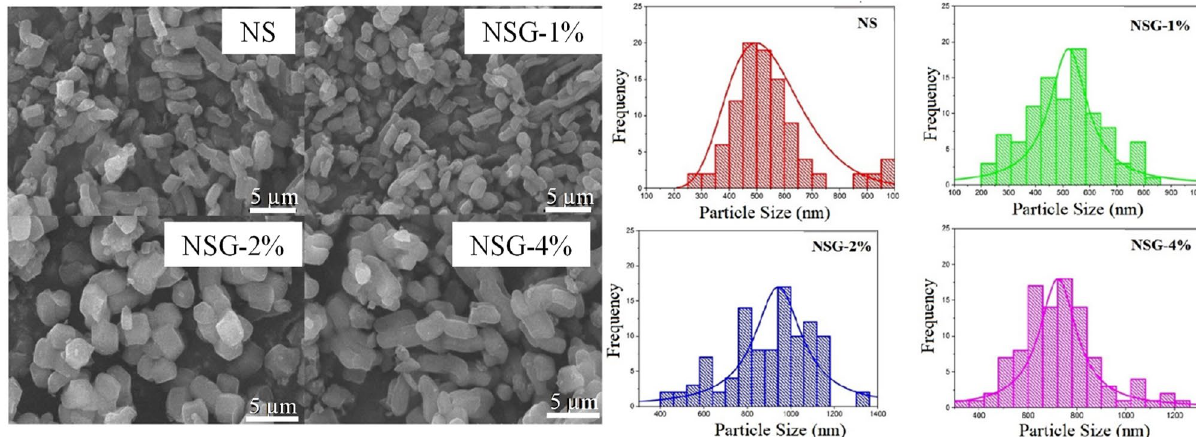
Figure 2. SEM analysis and the particle size distribution histogram of samples.